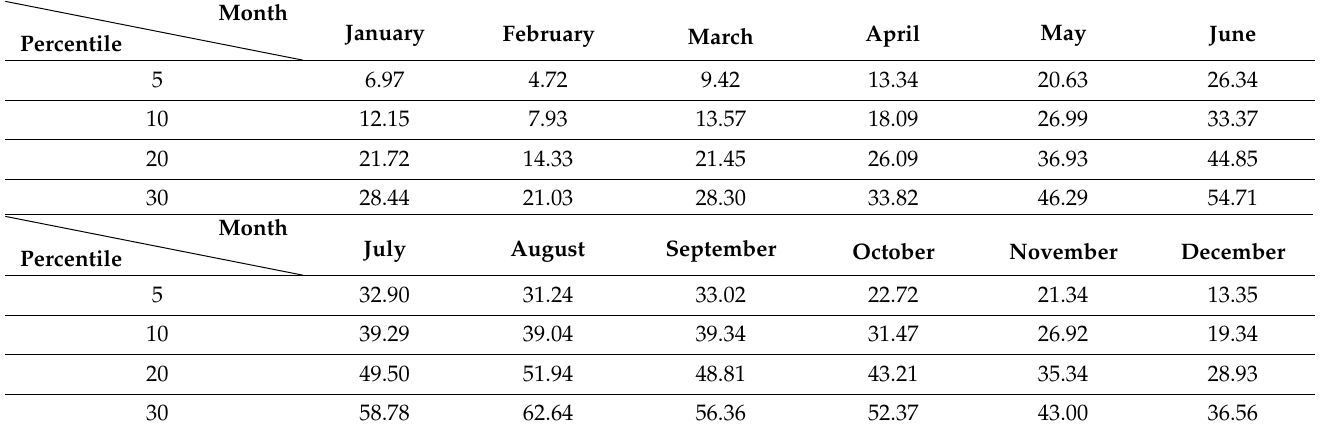
Table 4. Precipitation amounts (mm) corresponding to drought percentiles for the Temperate Region of Australia in different months.